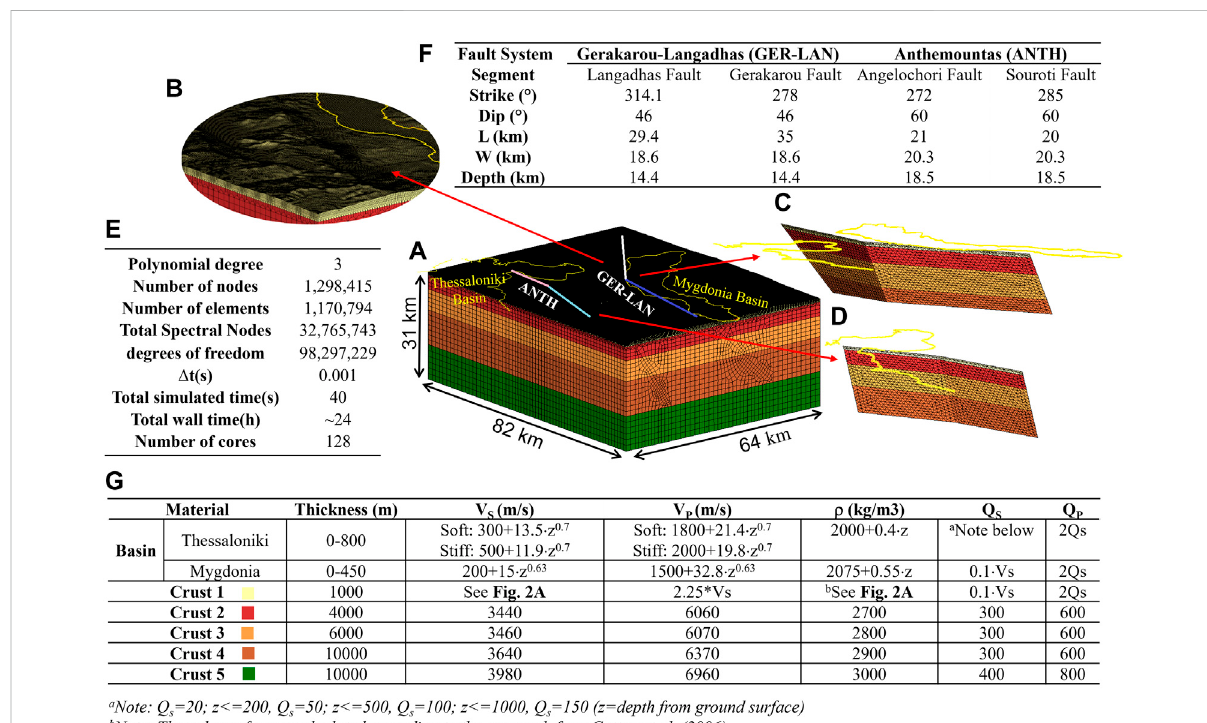
FIGURE 2 (A) Overview of the 3D numerical model and details on (B) mesh discretization in shallow layers and on the seismic faults, namely (C) GER-LAN fault and (D) ANTH fault. (E) Computational features. (F) Geometry of the seismic faults included in the numerical model. (G) 3D wave propagation model adopted for the sedimentary basins and for crustal rock layers (Shear-wave velocity: V S ; compressional wave velocity: V P ; soil density: ρ ; quality factors: Q S and Q P